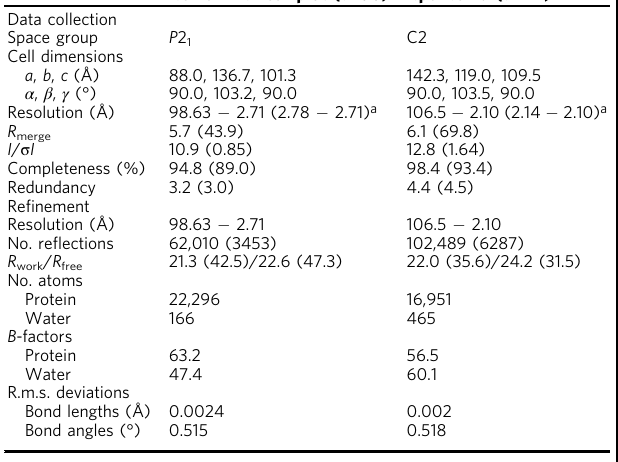
Table 1 Data collection and re fi nement statistics (molecular replacement).